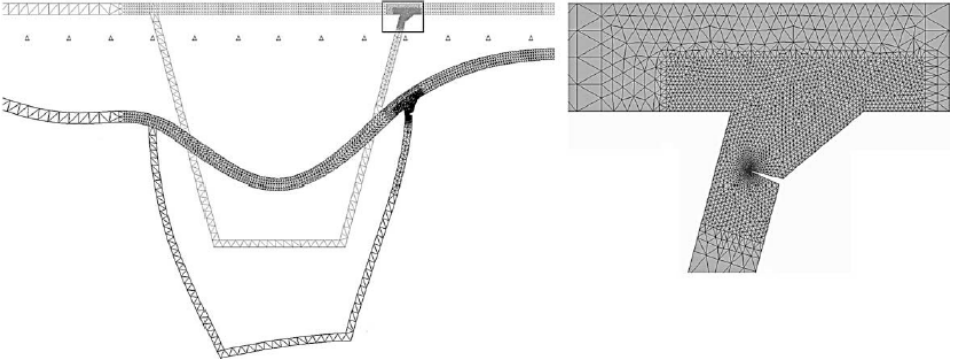
Figure 5: FE model of submodel analysis (Kiss, 2002).